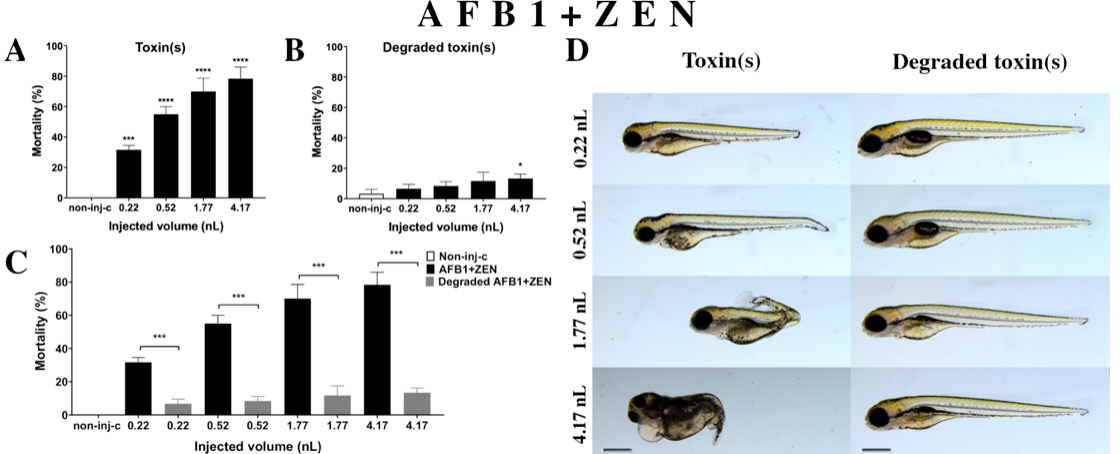
Figure 5. Effects of AFB1+ZEN mixture ( A ) and their degradation products ( B ) by the Rhodococcus erythropolis NI1 strain on 120 hpf zebrafish embryos. Mortality data are expressed as mean ± SD from three independent experiments in triplicate. Kruskal–Wallis followed by Dunn’s post-hoc test and Mann–Whitney test were used. Mortality values were compared to the non-injected control (non-inj-c) (* p < 0.05, **** p < 0.0001); lethality results of the initial AFB1+ZEN was compared to the degradation products of AFB1+ZEN ( C ) (*** p < 0.001). AFB1+ZEN and their degradation products induced developmental dysfunctions ( D ) in zebrafish embryos examined at 120 h. Representative phenotypic deformities induced by AFB1+ZEN were hook-like tail, tail deformities, pericardial and yolk edema, and head and lens distortion, and swim bladders were not developed at either dose; sublethal effects of their degradation products were not detected at either dose. Scale bar: 1 mm. Phenotypes of treated groups were compared to the non-injected control (non-inj-c) (Figure 1C). Quantitative data of developmental dysfunctions in zebrafish embryos are in the Supplementary Materials (Supplementary Table S1).